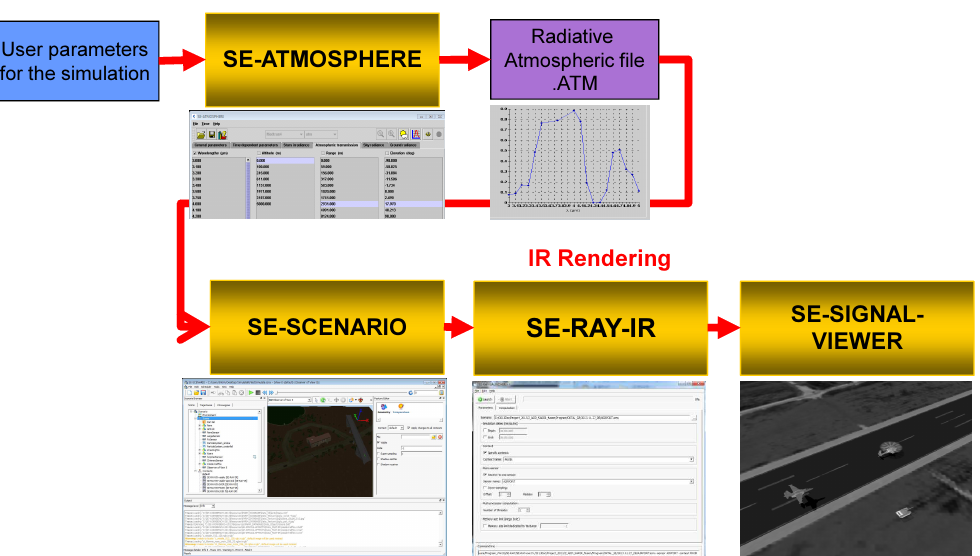
Figure 21. The flow of synthetic IR image generation using OKTAL-SE.